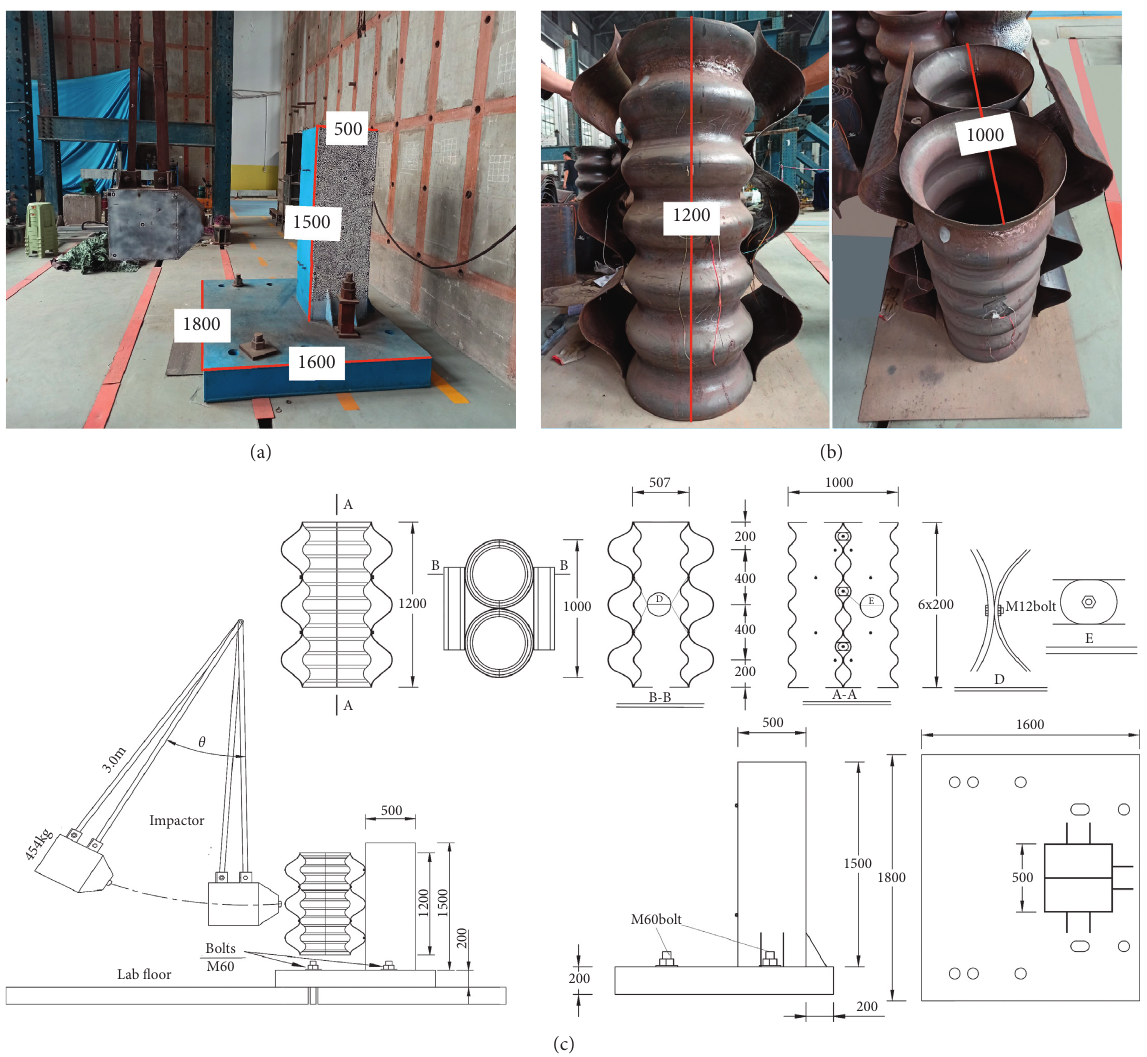
Figure 4: Field test model and geometric model of the impact test. (a) Column specimen, (b) CSP specimen, and (c) geometric